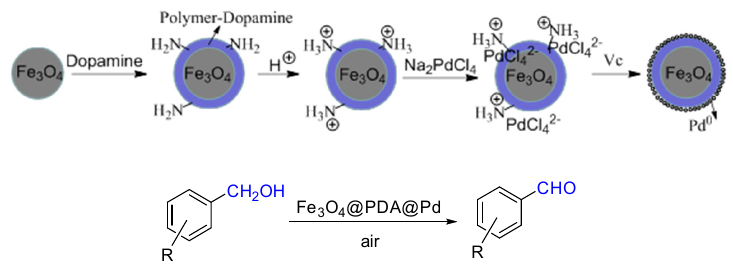
Figure 1. SEM images of Fe 3 O 4 and Fe 3 O 4 @PDA@Pd.